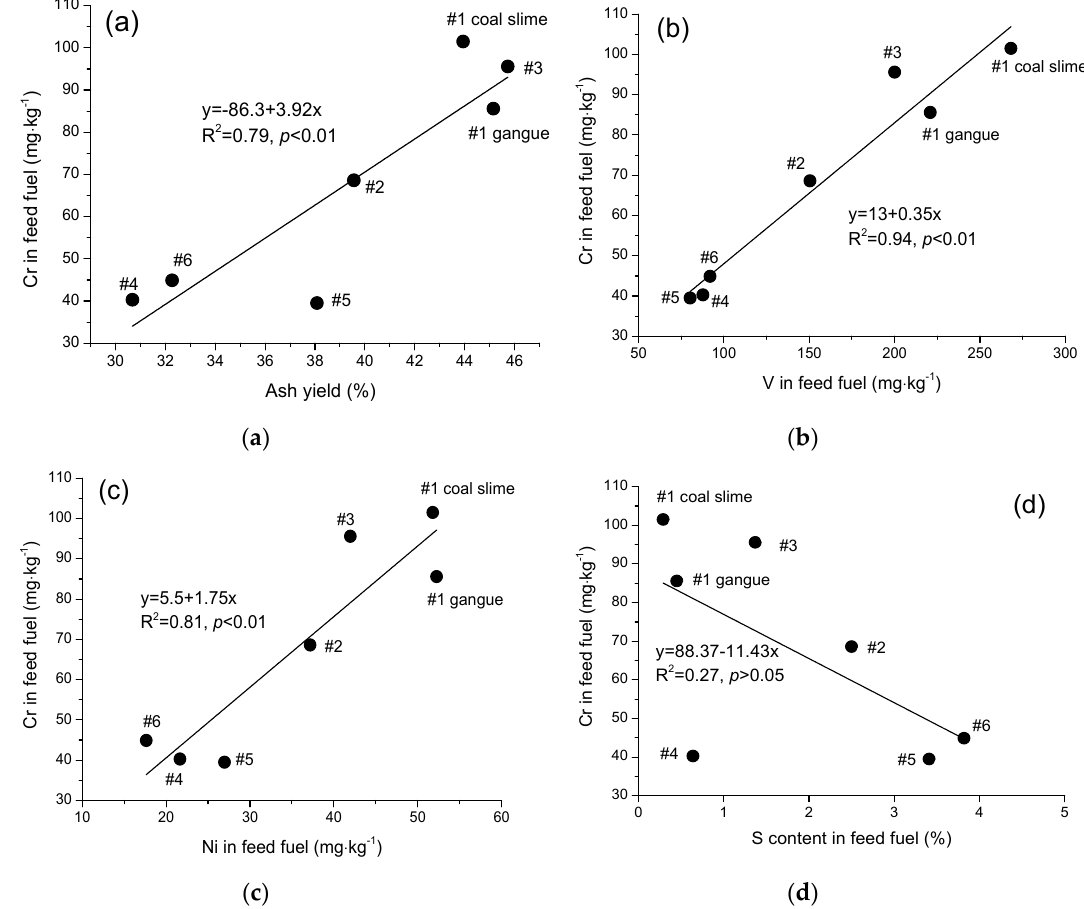
Figure 4. Correlations between the Cr and ( a ) ash yield, ( b ) V, ( c ) Ni, and ( d ) sulfur contents in whole-coal samples of six studied CFPPs (air-dried basis).